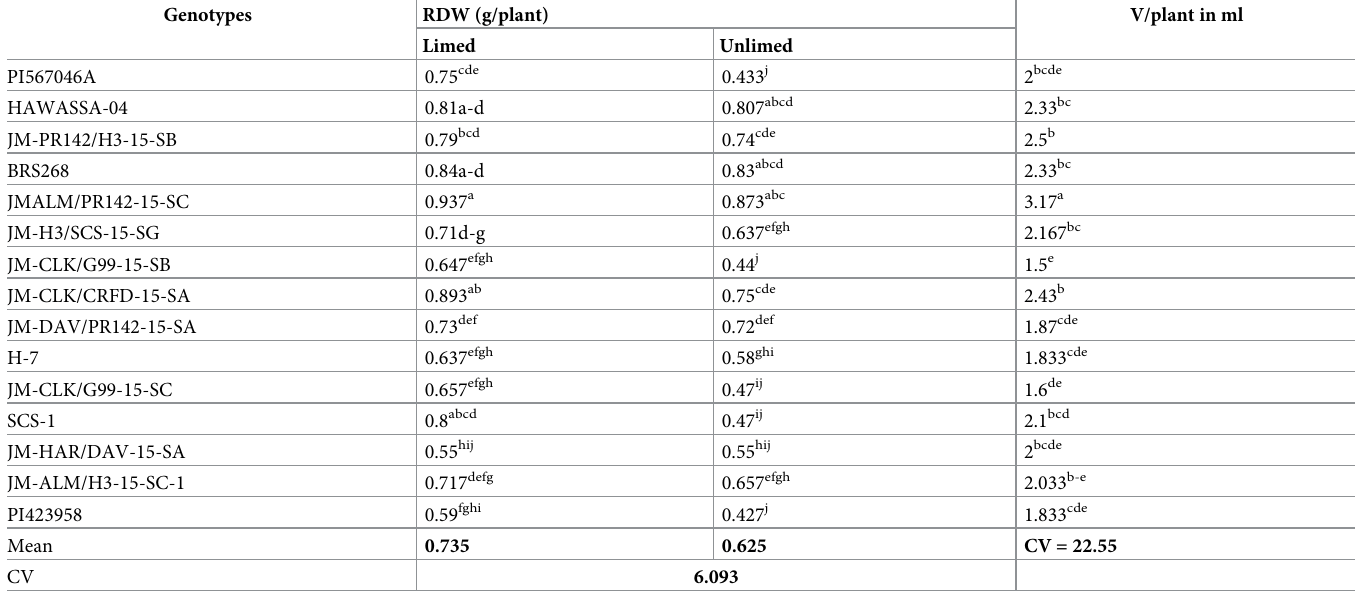
Table 8. Main effect of soybean genotypes for RV and interaction effect of lime and genotypes for RDW grown under limed and unlimed acid soils at Mettu on field during 2017 main cropping season.